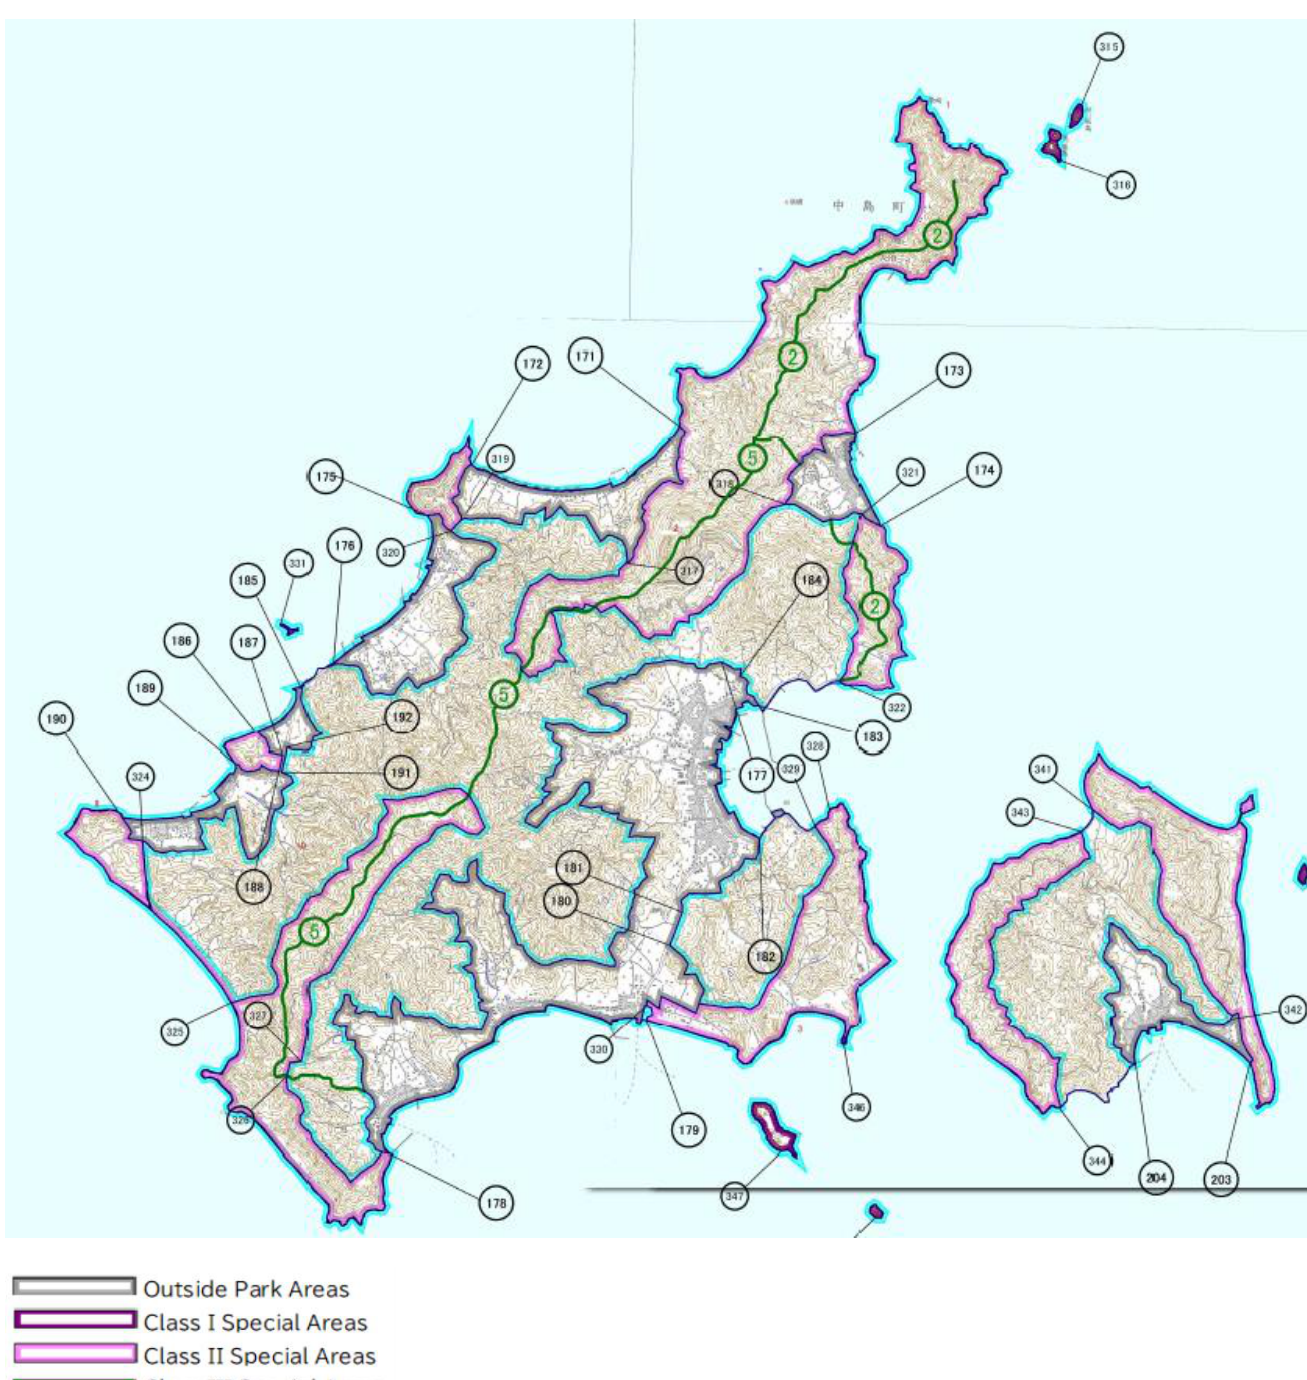
Figure 5. Special areas designated in natural parks